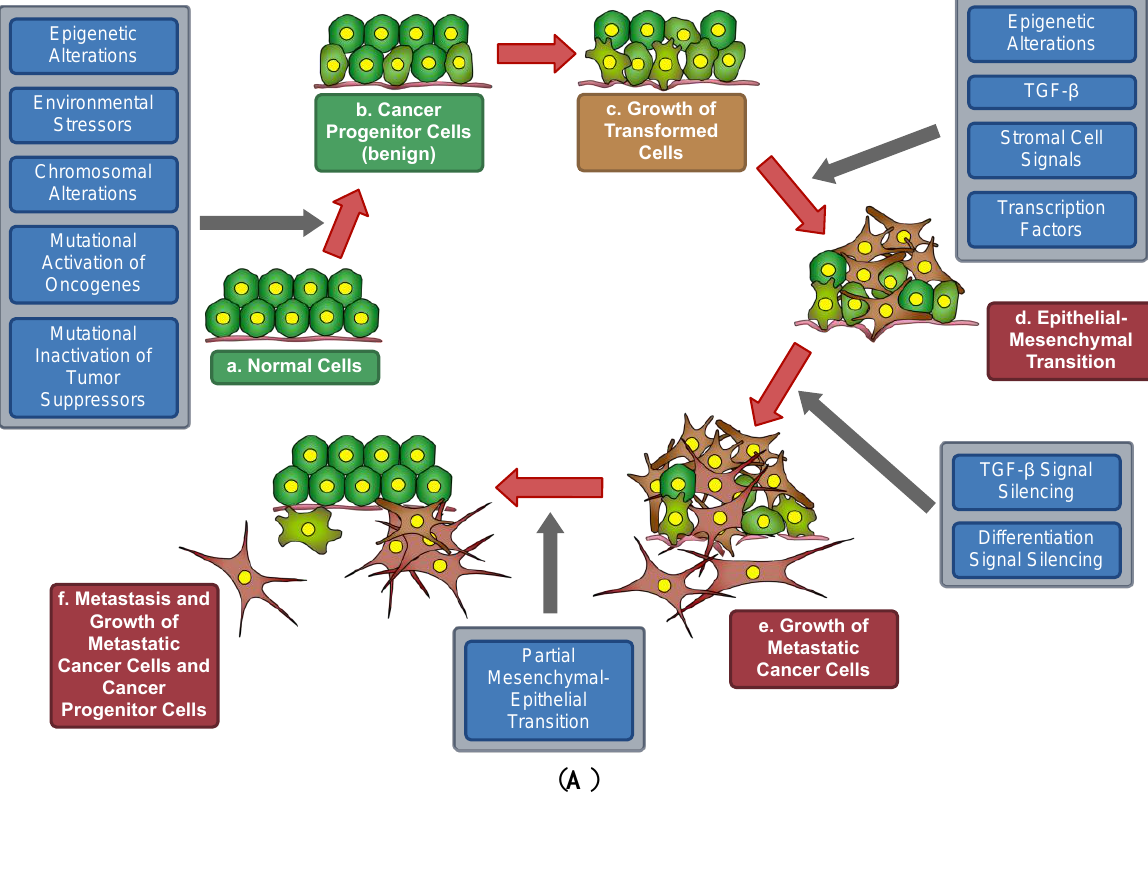
Figure 1. ( A ) Cancer progenitor cells and progression of metastatic cancer. a : hexagons with yellow dots represent normal cells; b : faded green, distorted hexagons with yellow dots represent cancer progenitor cells; c : progenitor cells are increasing in number; d : star-like brown cells represent the metastatic form of cancer cells, a mixed population of progenitor and adult cells; e : overgrowth of metastatic cells; f : both metastatic and adult progenitor cells leave site. Progression: Cancer progenitor cells develop from normal cells ( a to b ); After growth ( b to c ), they undergo EMT ( c to d ); Differentiation signals decrease and growth signals increase, producing a combination of progenitor and adult metastatic cancer cells ( d to e ); After the outgrowth of metastatic cells, translocation to a distant location occurs ( e to f ); ( B ) Model for the development of grade-specific cancers. Cancer progenitor cells pause at each grade of differentiation and proliferate from that grade while maintaining the ability to differentiate further; and ( C ) Model of the development of grade-specific cancers. Some cells progress further through differentiation than others, stop differentiation, and then proliferate, giving rise to clonal populations of cancer cells at distinct